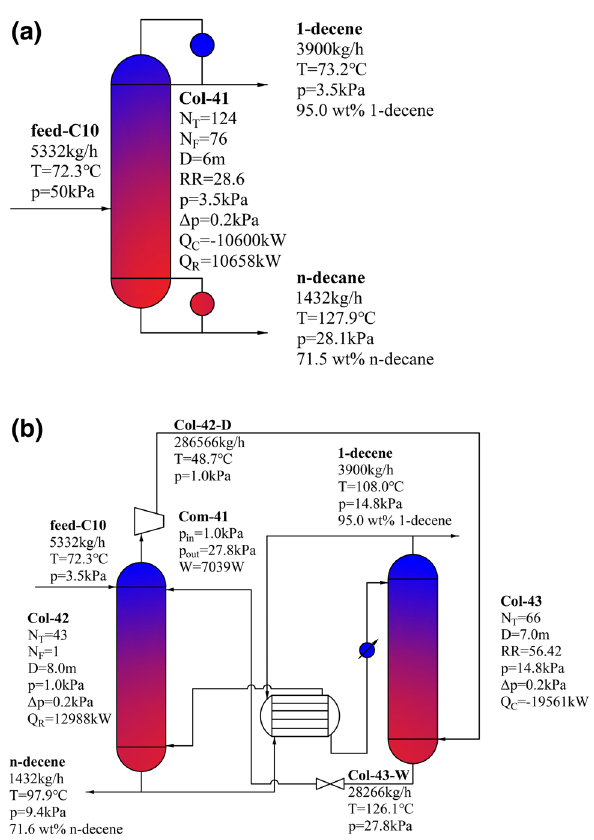
Fig. 5 Process and simulation results of the C10 α -olefins separation. a TD process, b DPTD process